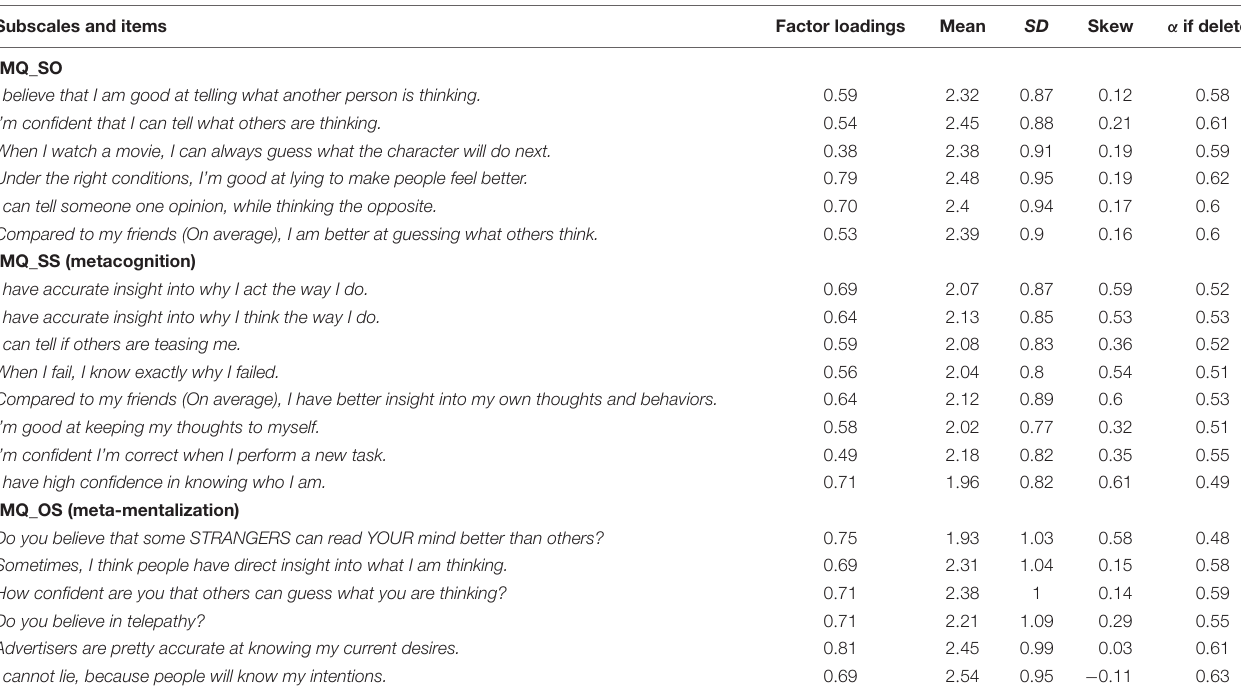
TABLE 2 | The IMQ scales: items, alpha reliabilities, standard deviations, and factor loadings. Subscales and items Factor loadings Mean SD Skew α if